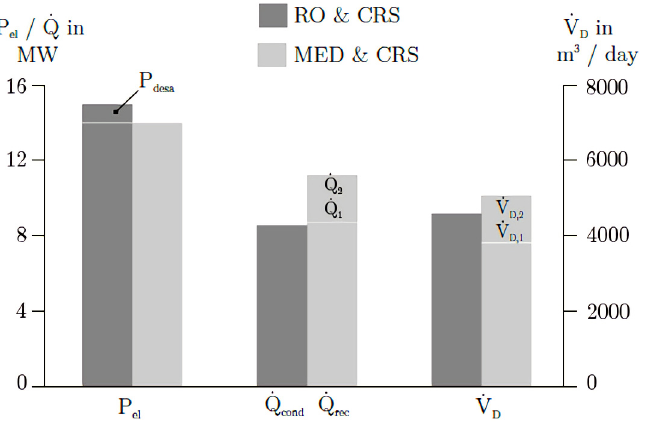
Figure 8. Comparison between the energy recovered, heat and water production for the two CRS+D con fi gurations.